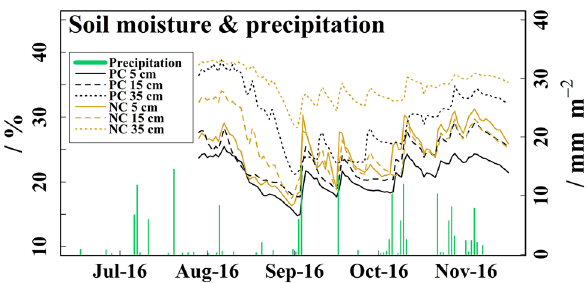
Fig. 2 Daily mean soil moisture in strawberry cultivation, measured at 5, 15 and 35 cm soil depth under plastic coverage (PC) and no coverage (NC), respectively, and daily precipitation. The data gap in soil moisture from July to mid-August was due to a technical mal-